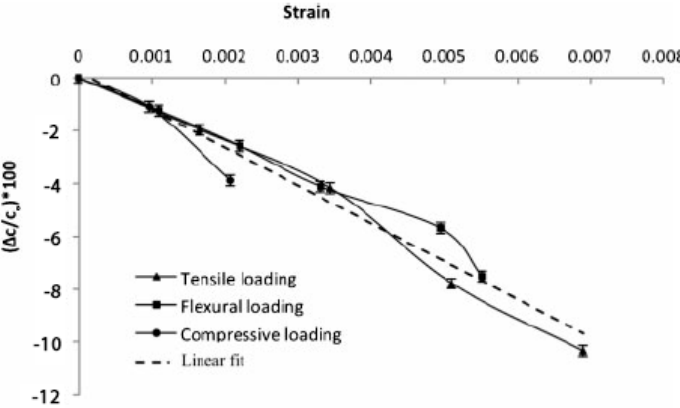
Figure 8. Effect of cell embeddings in sandwich panel mechanical performance [38].